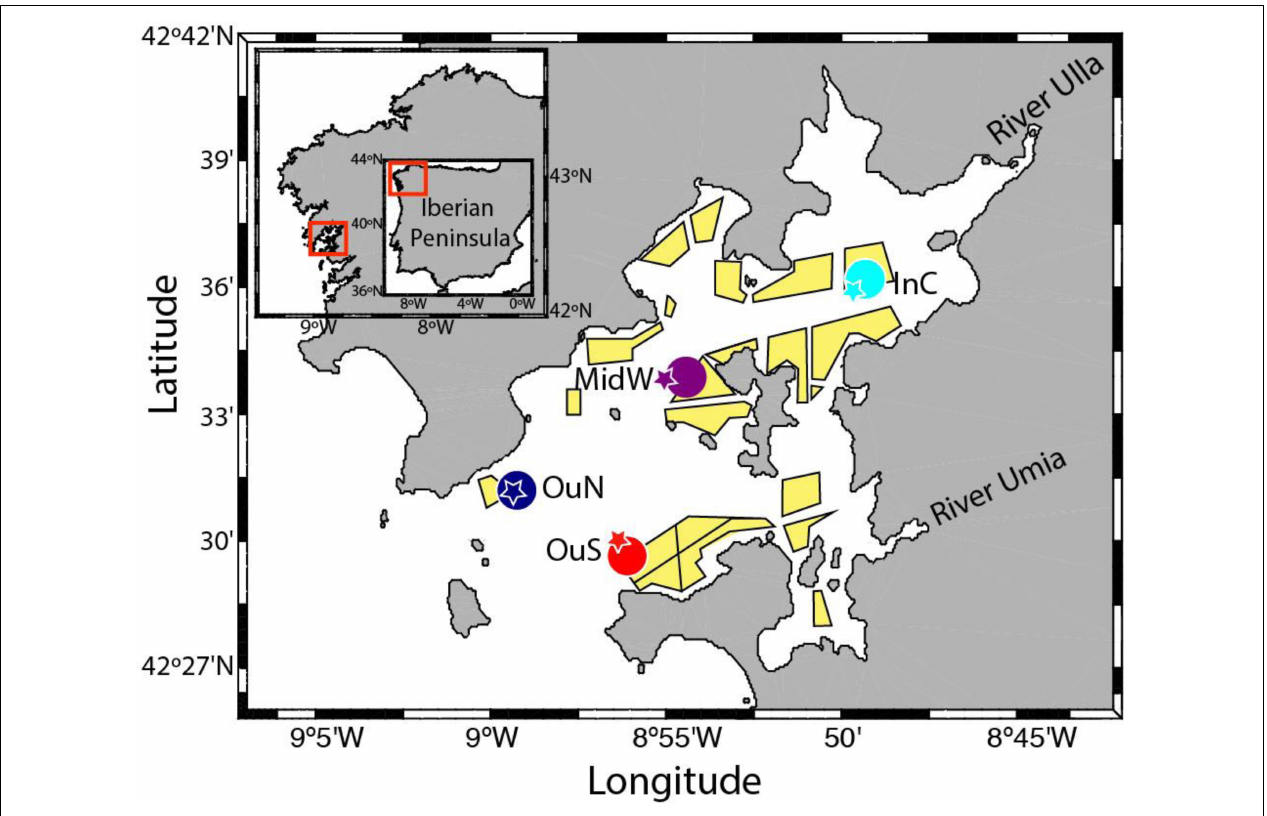
FIGURE 1 | The experimental mussel cultivation sites and nearby environmental monitoring stations in the Ría de Arousa (NW